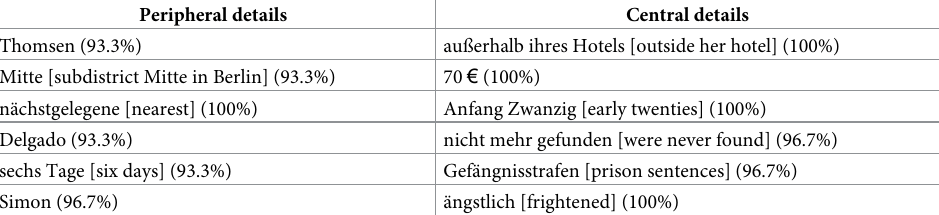
Table 3. The six details of the GGSS-1 story most frequently rated as peripheral/central (percentage of highest ranking among 30 independent raters in